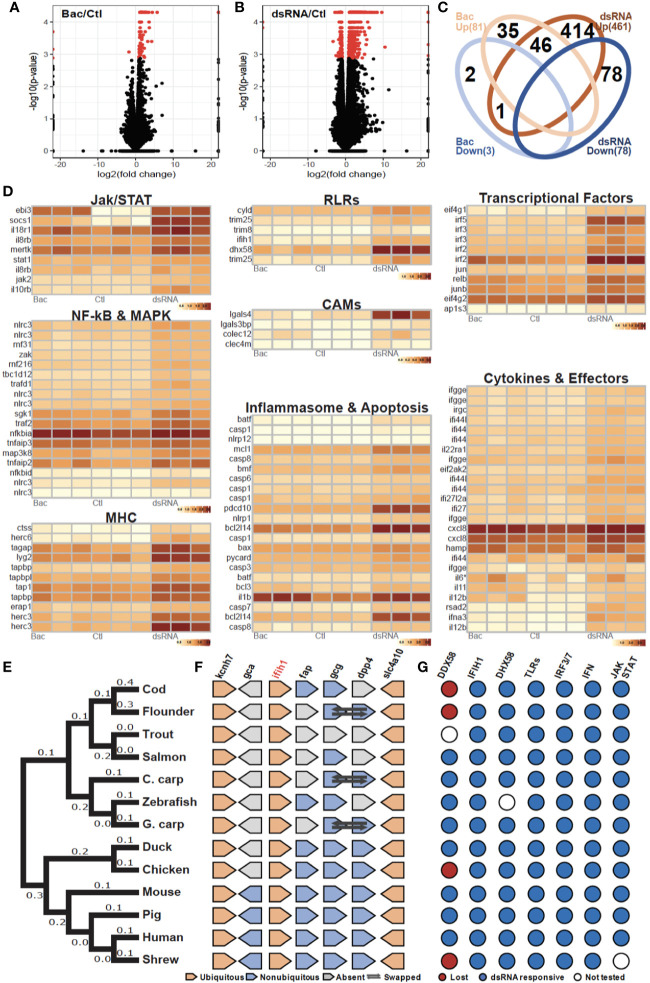
Evolutionarily conserved antibacterial and antiviral response of cod macrophages (A, B). Volcano plots of the expression patterns and statistical significance (shown in red, FDR < 0.05) of genes across three biological samples challenged with (A) bacteria-derived microbe-associated molecular patterns (MAMPs) (Bac) and (B) dsRNA contrasted with control samples (Ctl) (C). Venn diagram showing number of overlapped up-regulated (UP) and down-regulated (DOWN) genes that had been annotated among Bac and Plc (D). Transcript abundance (log10FPKM+1) of selected DEGs, grouped based on shared signaling pathways (E). Phylogenetic tree of ifih1 from 13 vertebrates. Number of nucleotide substitutions per site are shown next to each branch (F). Synteny analysis of ifih1. Pentagon shapes represent each gene, pointing in the direction of transcription. Ubiquitous genes are orange, absent genes are grey, and non-ubiquitous genes are blue. Dark arrows indicate swapped genes (G). Antiviral responsiveness of the “RLRs-TLRs-IRF3/7-type1IFN-JAK/STAT” axis in 13 vertebrates, as shown by published studies. Red circles indicate lost genes, white circles untested genes, and blue circles responsive genes.